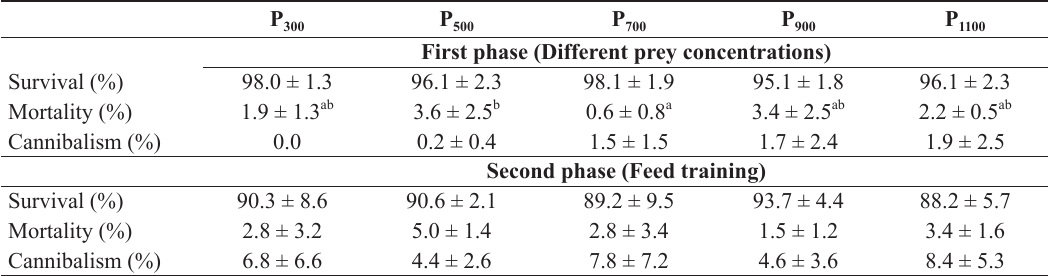
Survival, mortality and apparent cannibalism rates (± standard deviation) of Hoplias lacerdae juvenile at the end of the two experimental phases.